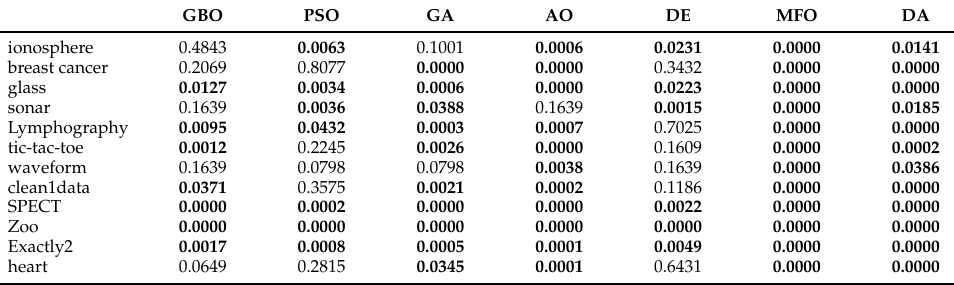
Table 13. Results of the Wilcoxon rank-sum